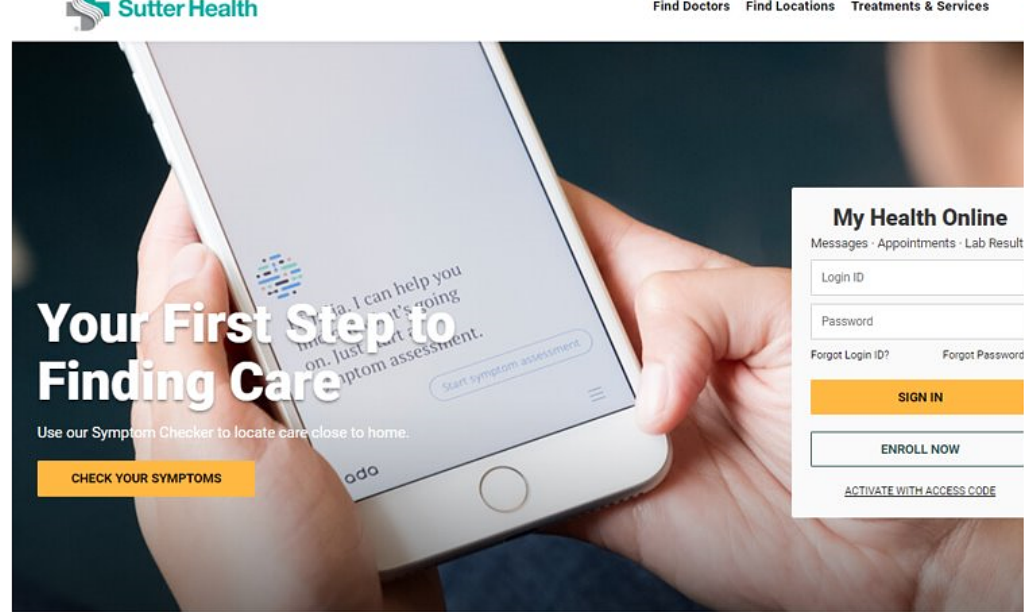
Figure 1. Screenshot of the Sutter Health webpage during the symptom checker launch, May